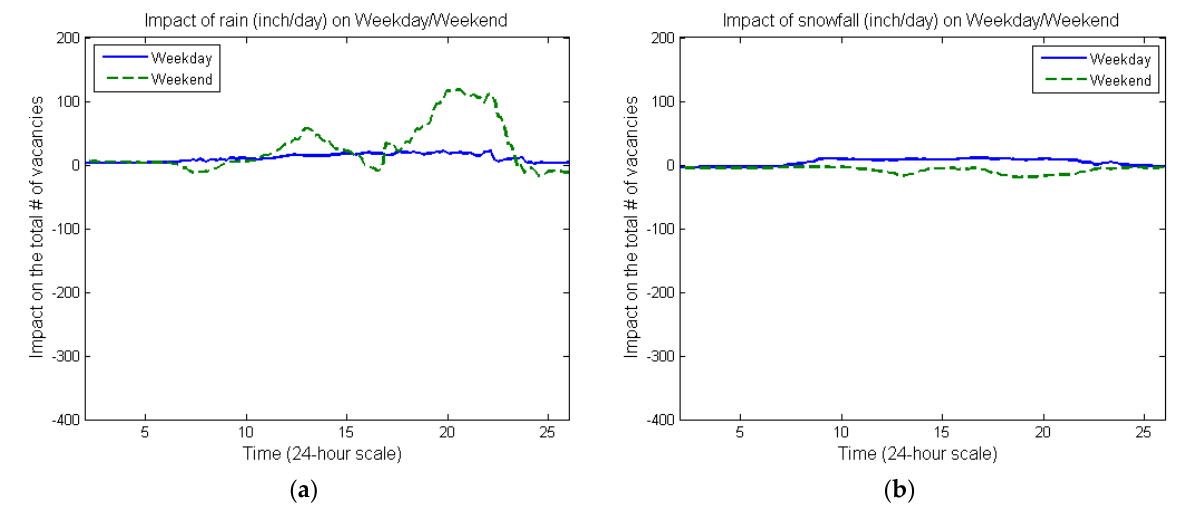
Figure 6. ( a ) Impact of rain (inch/day); ( b ) impact of snowfall (inch/day).